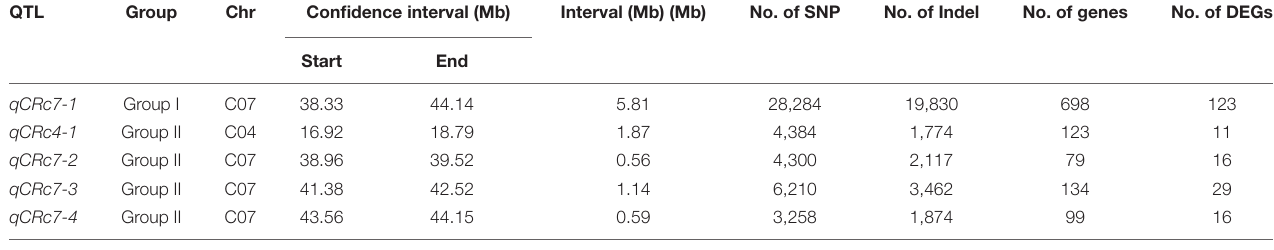
TABLE 2 | The CR-quantitative trait loci (QTLs) identified in groups I and II.